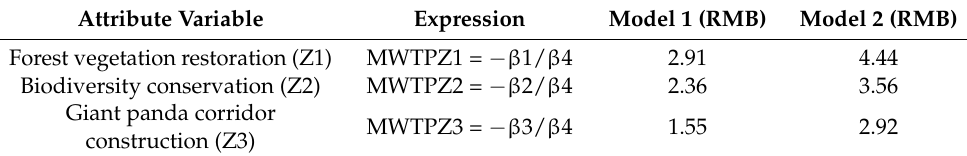
Table 4. The marginal value of ecological restoration attributes.